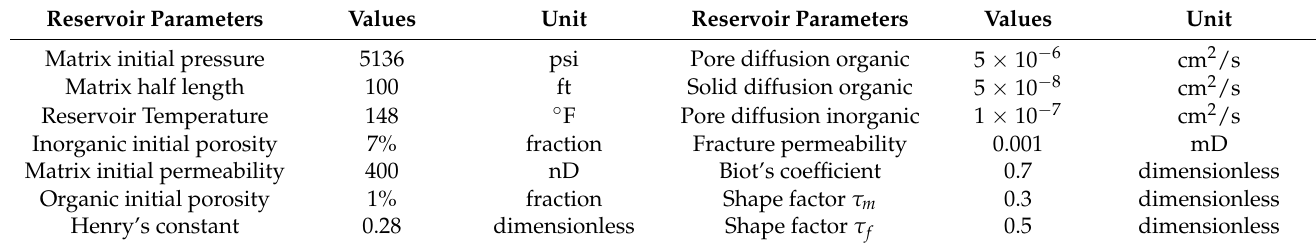
Table 3. Model base case